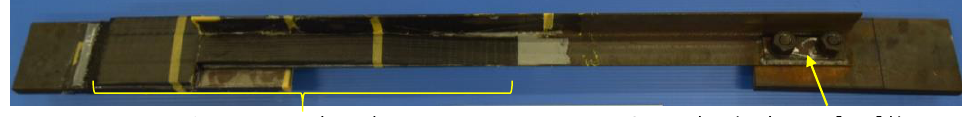
Figure 10. Specimen with CFRP strengthening.